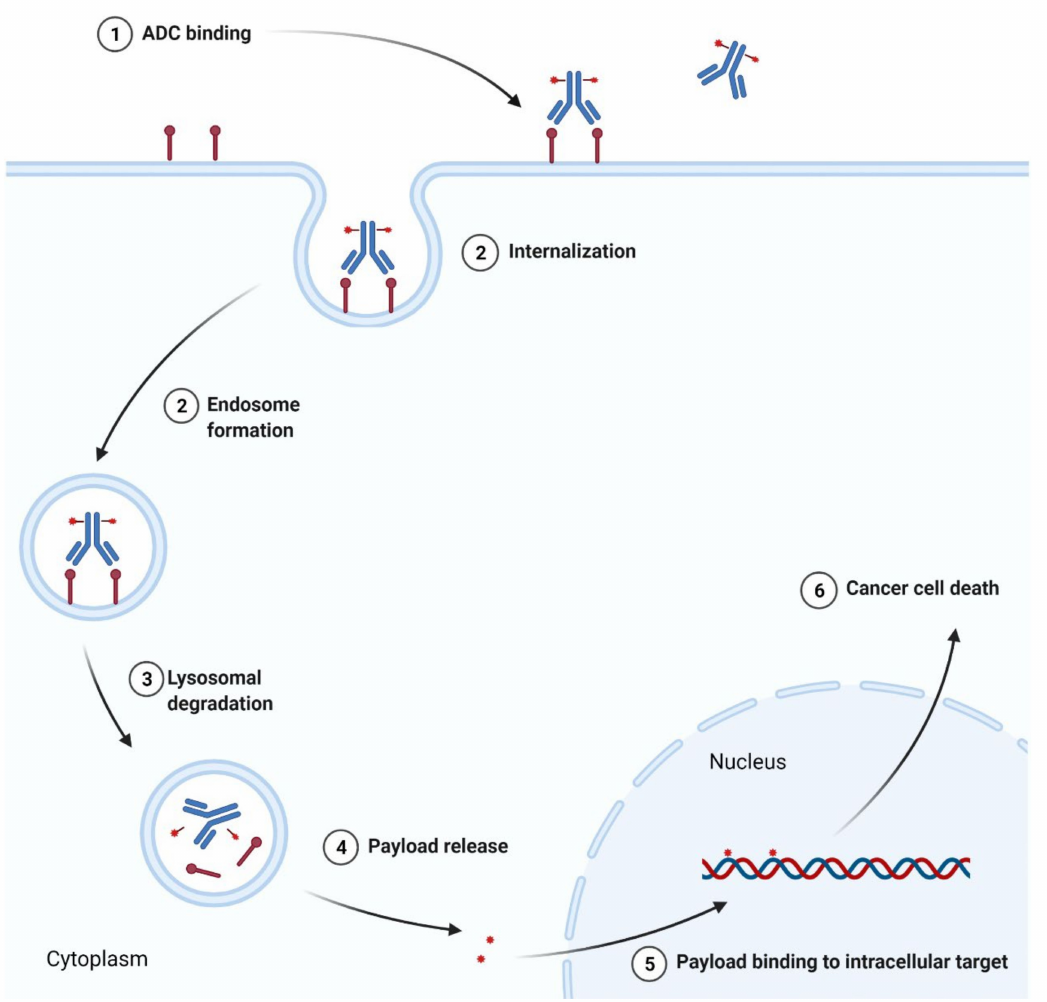
Figure 11. General mechanism of action of antibody-drug conjugates. ADC : antibody-drug conjugate. Adapted from “Intracellular layout—endocytosis pathway,” by BioRender.com (2021). Retrieved from https://app.biorender.com/biorender-templates (accessed on: 8 December